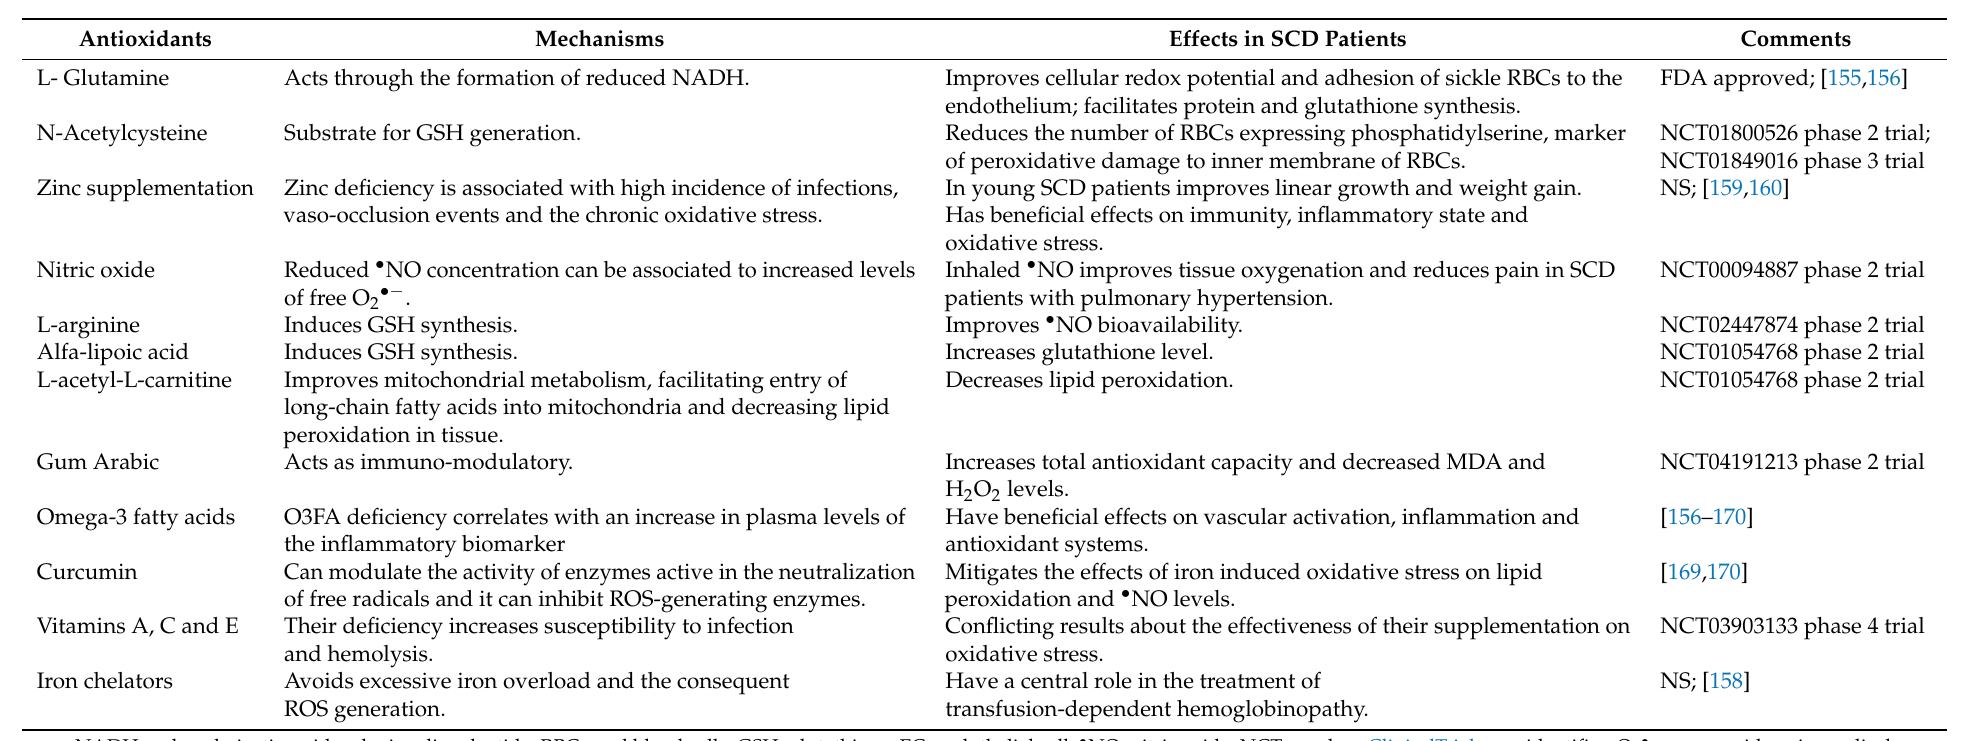
Table 2. Antioxidants in SCD